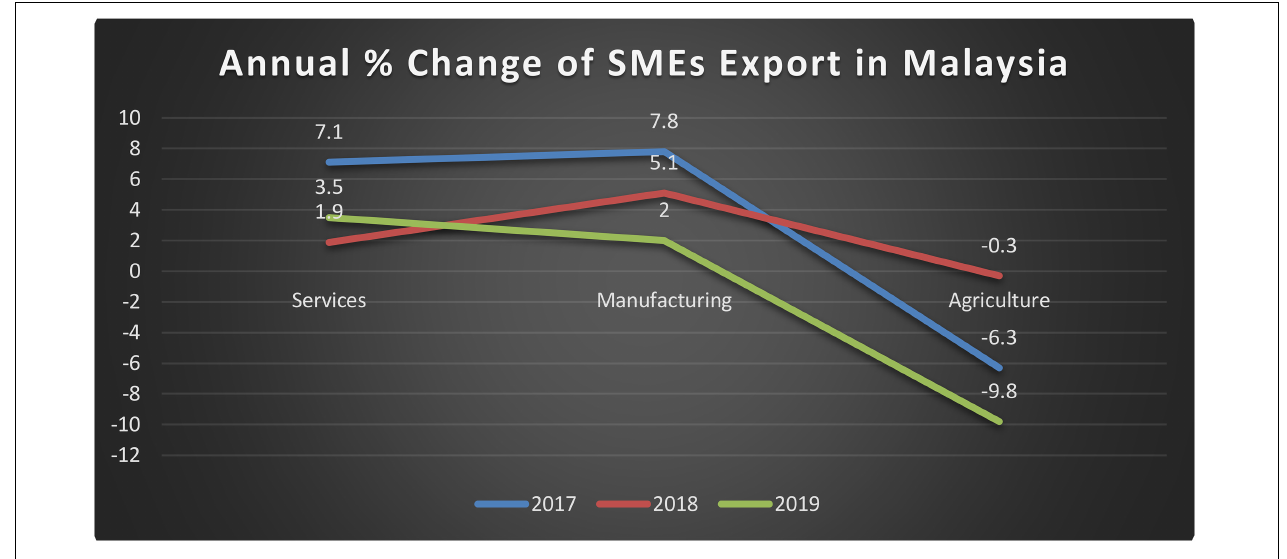
FIGURE 1 | Annual % change in SMEs export in